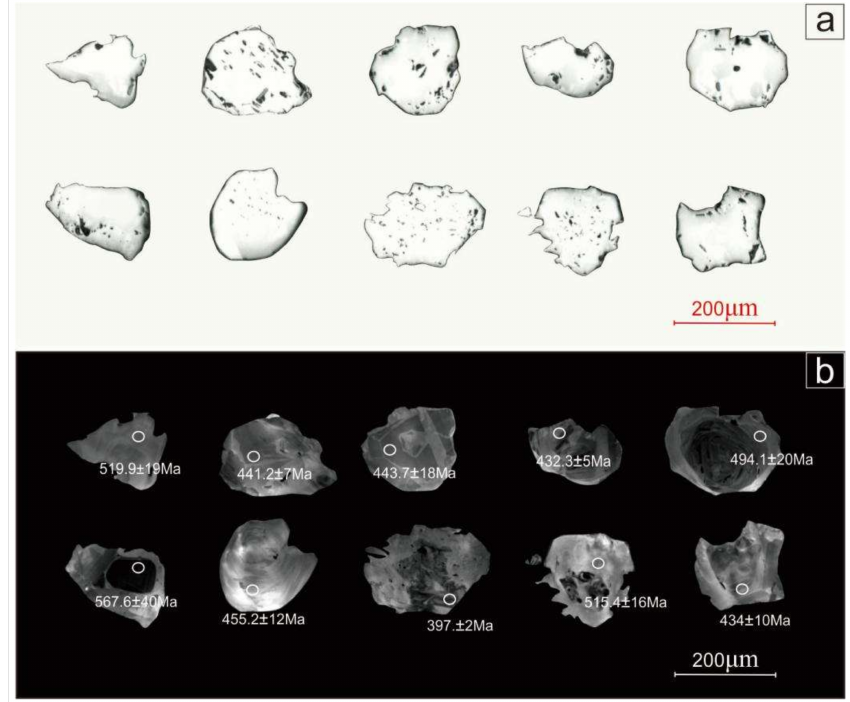
Figure 4. ( a ) Reflected light and ( b ) cathodoluminescence images of cassiterite in the Jialong Cu–Sn deposit.